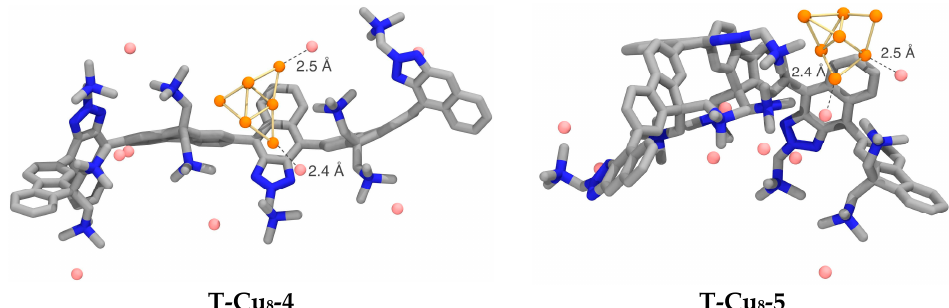
Figure 5. The optimized structures of complex T-Cu 8 -4 and T-Cu 8